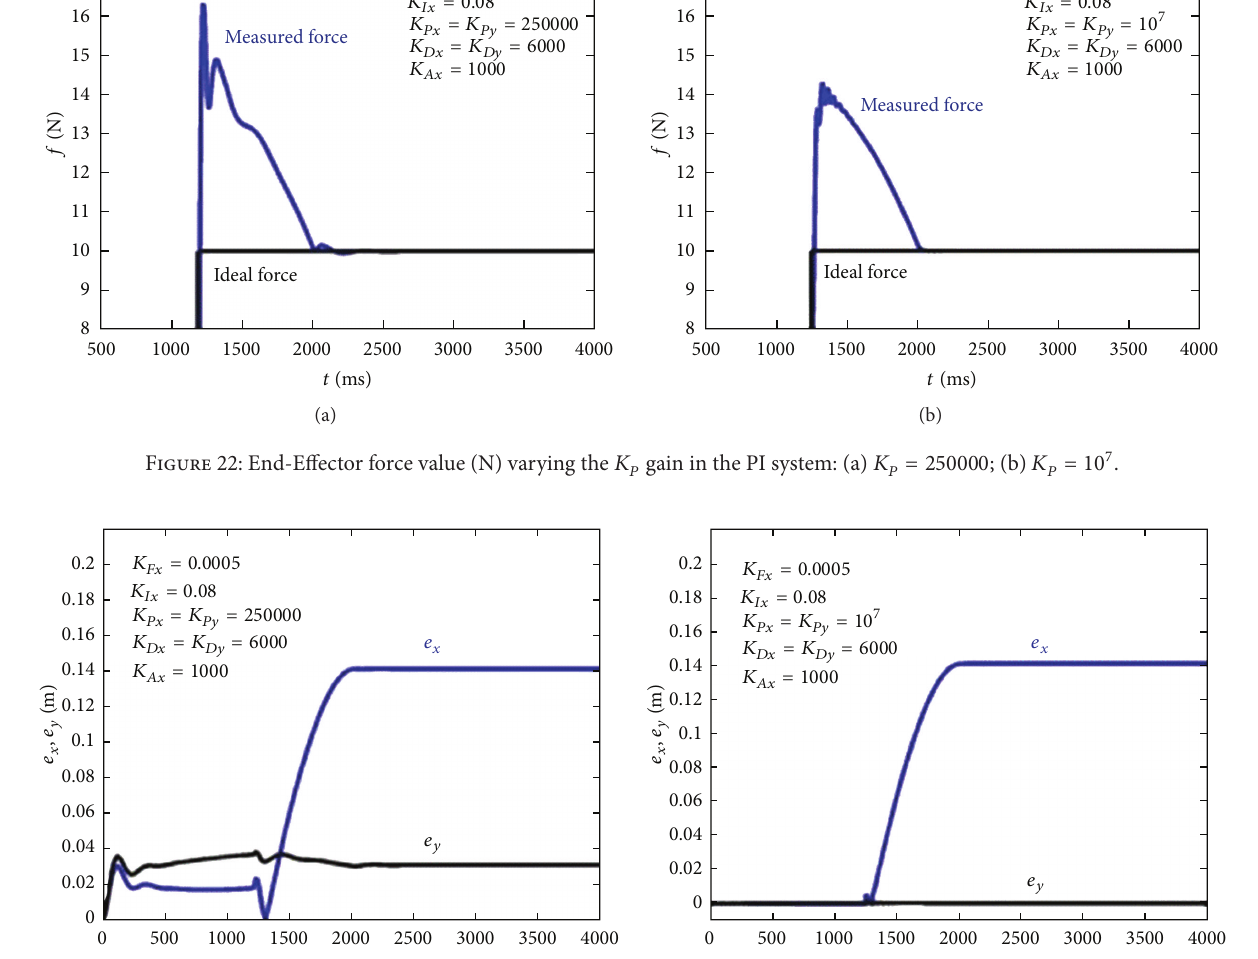
graphs indicates that the P system is more influenced by the environment (varying 𝐾 𝐴 ) with respect to the PI system. By means of the analysis of Figures 26(b), 26(c), 27(b), and